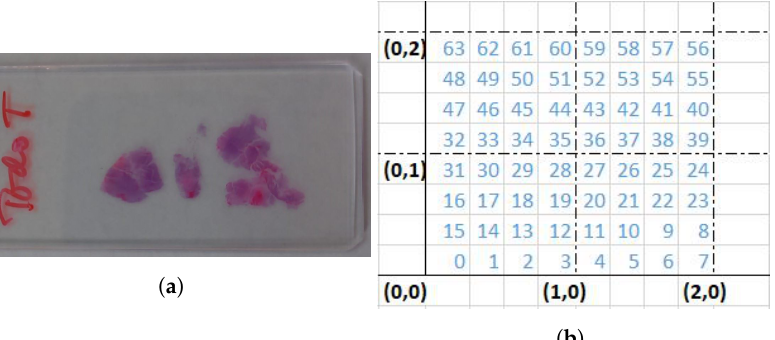
Figure 2. HS image dataset: ( a ) Brain histology sample, ( b ) labeling of 1/4-pixel movements around start coordinates (0,0).